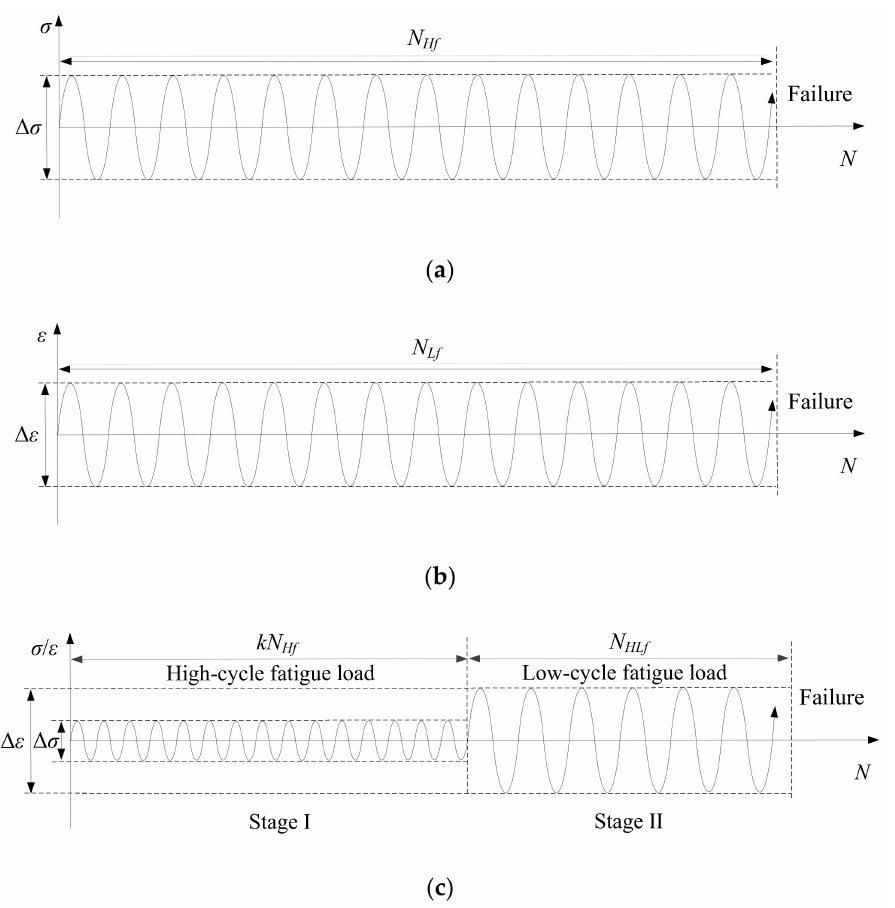
Figure 2. Loading methods: ( a ) HCF loading mode; ( b ) LCF loading mode; ( c ) HLCF loading